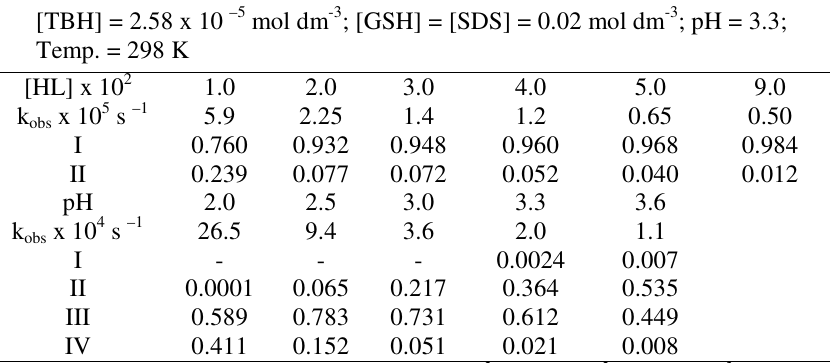
Table 2. Effect of added [HL] and [H+] on the rate of reaction and on mole fraction of FeL 3